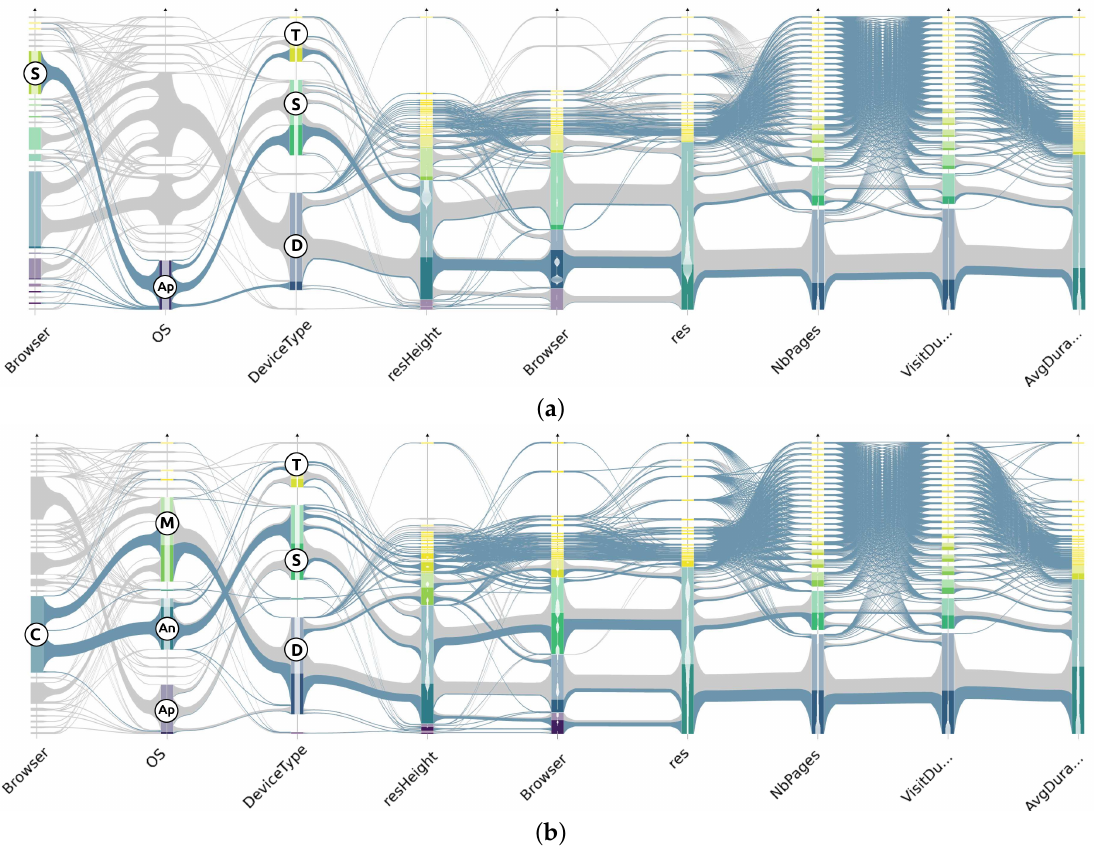
Figure 9. Subset highlighting on the C2C website dataset with k = 30: Selecting an aggregate highlights the subset over all the plot. ( a ) Selection of Apple Operating System (iOS or macOS) shows that users only use Safari browser (S) and mainly for mobile devices : tablets (T) and smartphones (S); ( b ) Selection of Chrome browser (C) highlights users using either desktop devices (D) and smartphone devices (S) and using the corresponding operating systems: Microsoft (M) and android